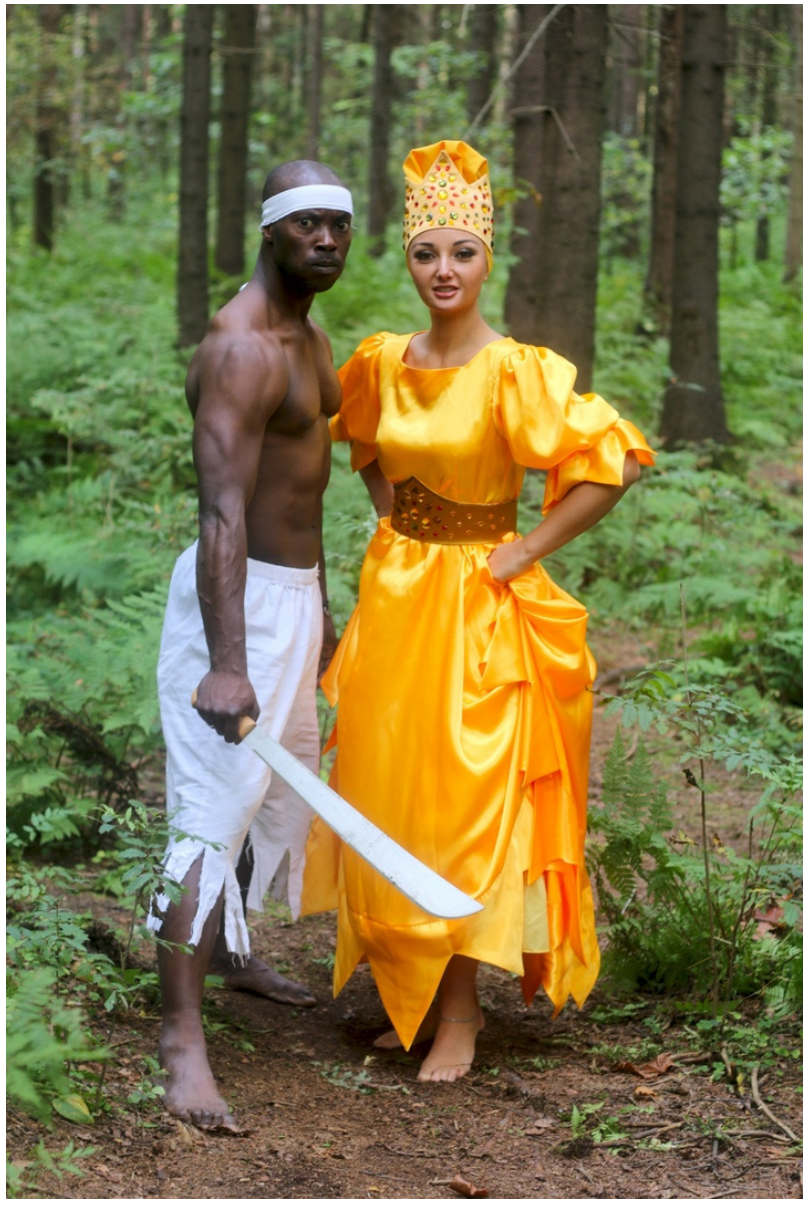
Figure 4. Dance teachers Iya Baval and Ildemar Rodriguez from the Latin Dance school Bembé (St. Petersburg, Russia) perform orisha dance (Ochun and Ogun).